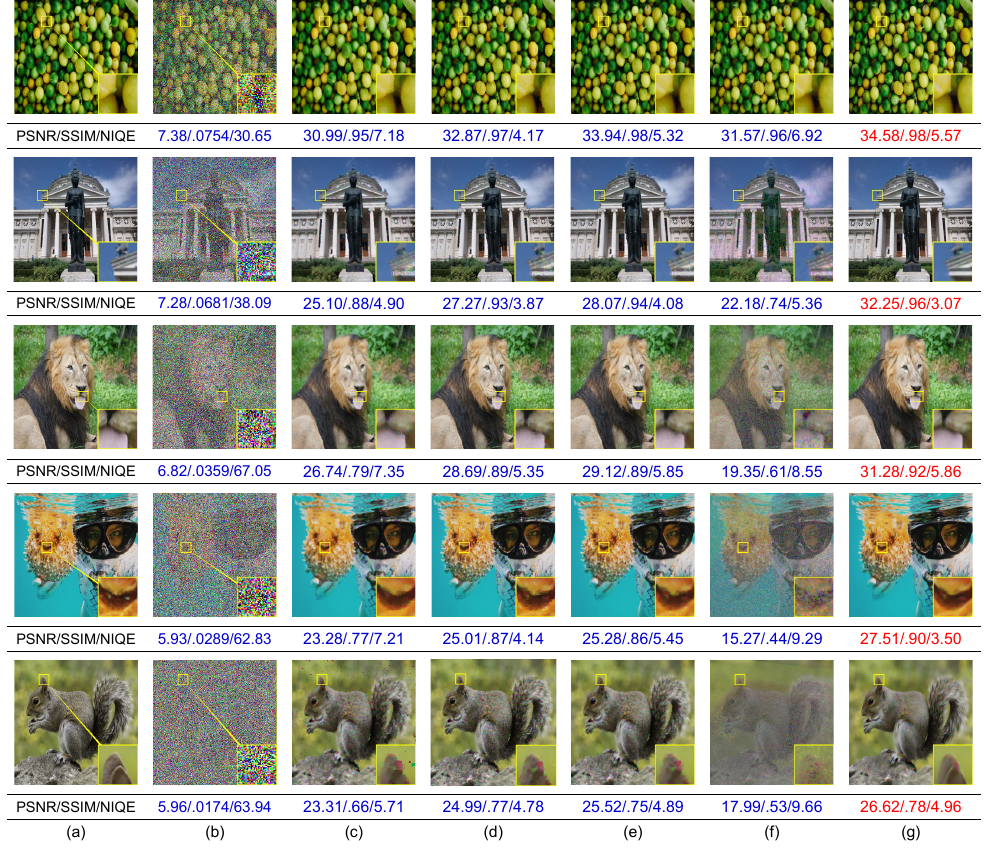
Figure 5. Examples of denoising results for color images with 50-90% noise added using different methods. We show the corresponding objective scores below the measured images. The best scores are in red. ( a ) Original image. ( b ) Images with 50%, 60%, 70%, 80%, 90% noise added (from the top to bottom rows). Denoising results using ( c ) MDBUTMF [8], ( d ) DAMF [9] , ( e ) FASMF [10], ( f ) MMAP [11], and ( g ) the proposed